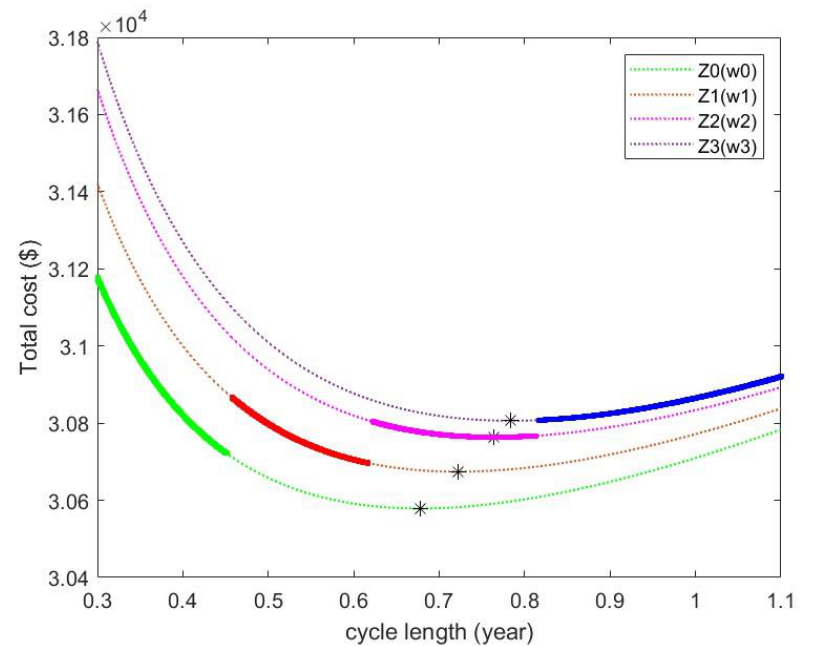
Figure 3. The scrap model total cost versus cycle length for each breakpoint. Bold line: permissible limits of each range, *: the answers for each range are obtained from Equation (21).